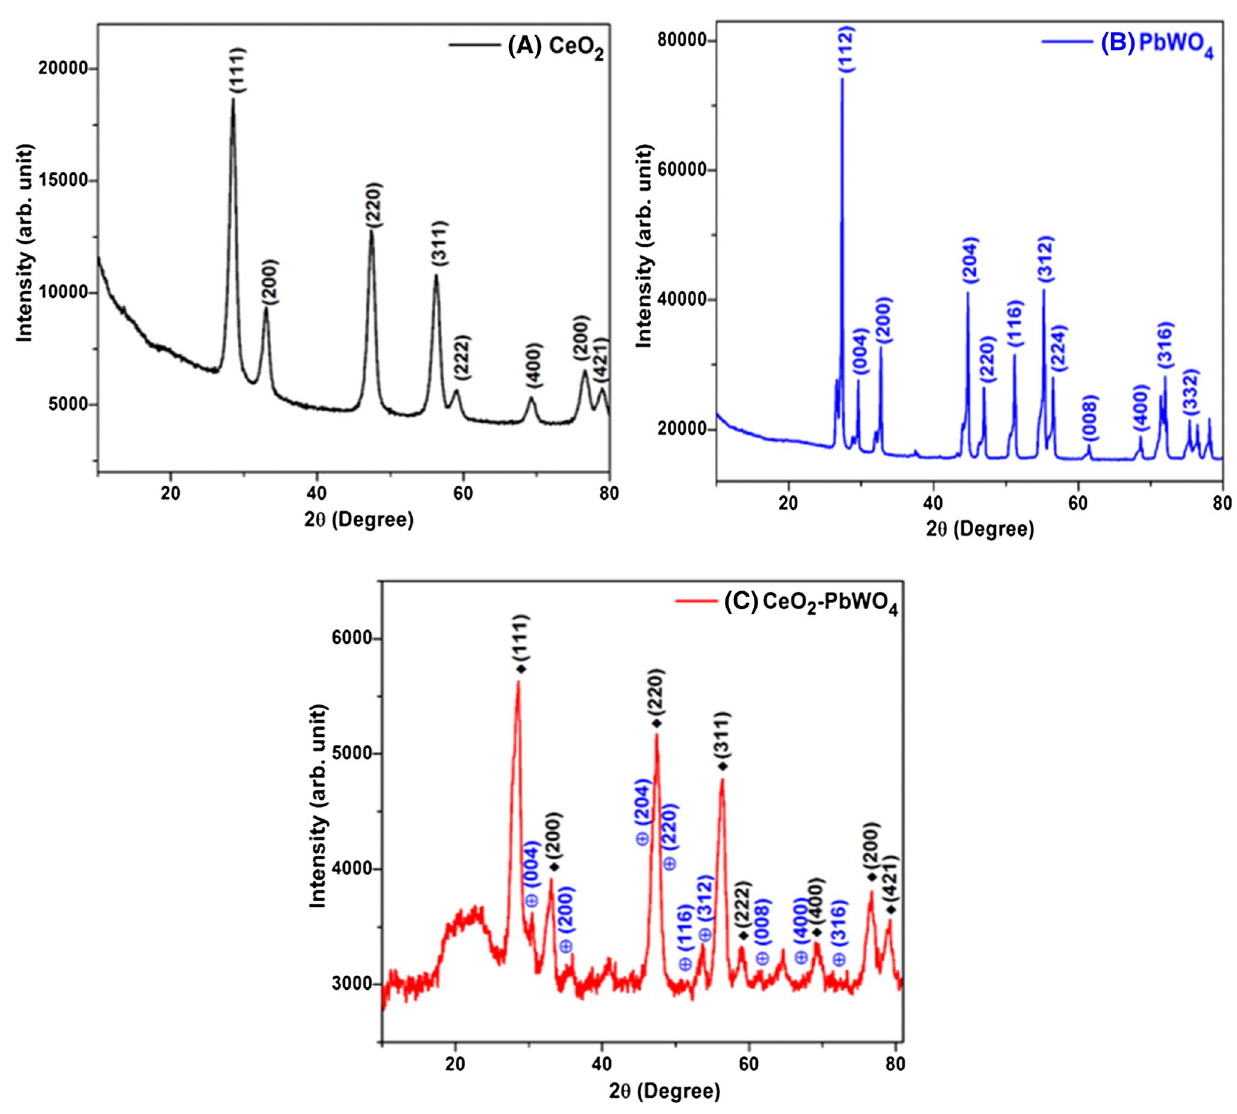
Fig. 1 XRD pattern of as obtained